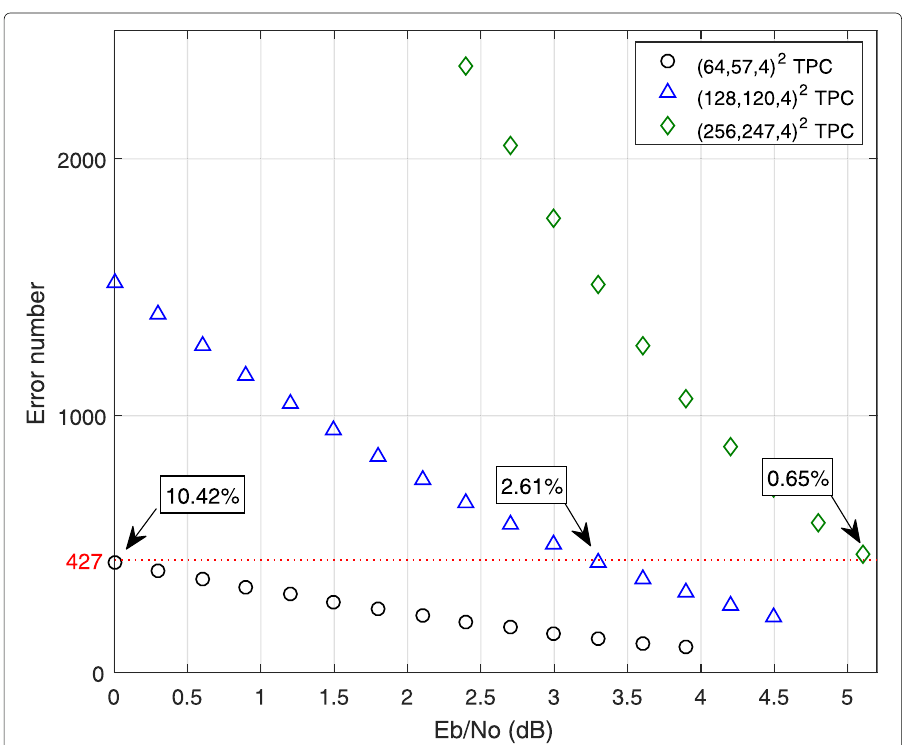
Fig. 10 The average number of errors according to the SNR region of the three types of TPCs received via the AWGN channel